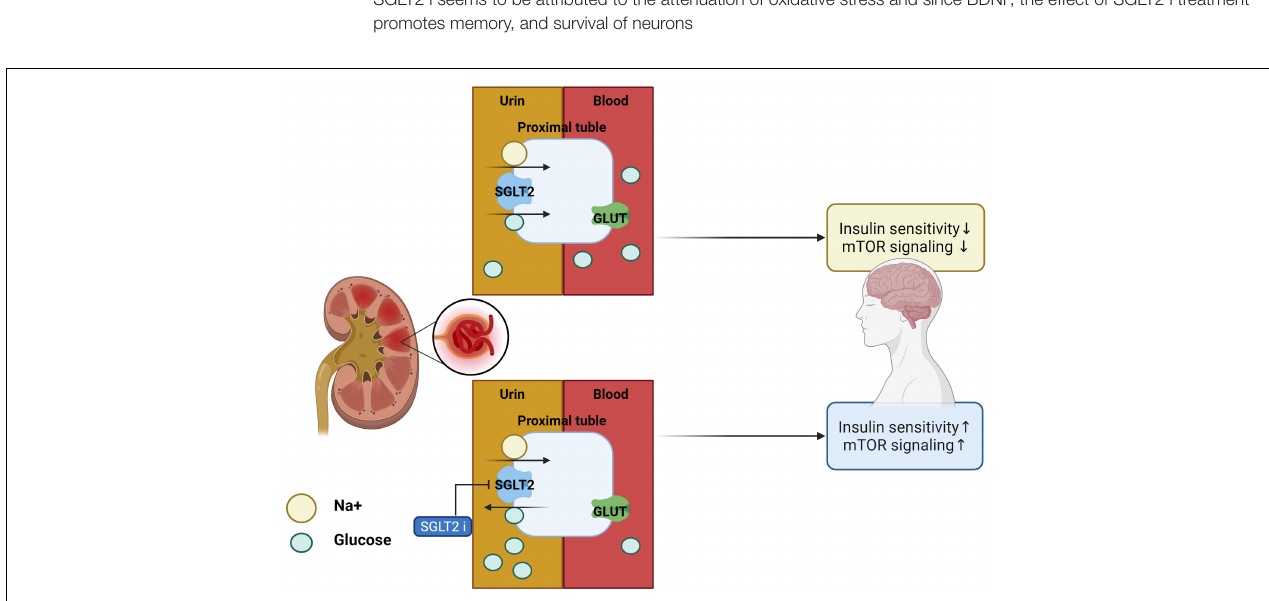
FIGURE 3 | Effects of SGLT2 inhibitor in the AD brain. With SGLT2 inhibitor, insulin sensitivity and mTOR signaling in the brain are improved, as excess glucose from insulin resistance is filtered out by the